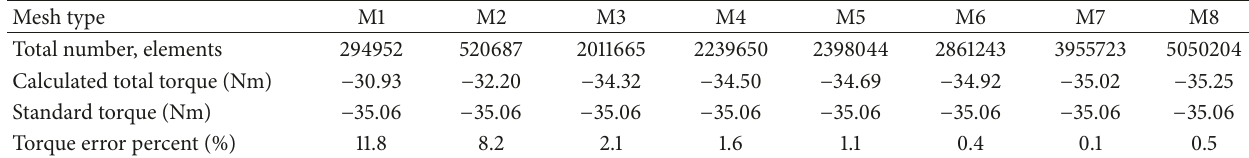
Table 9: Mesh dependent test analyzed for PCD = 500 mm.